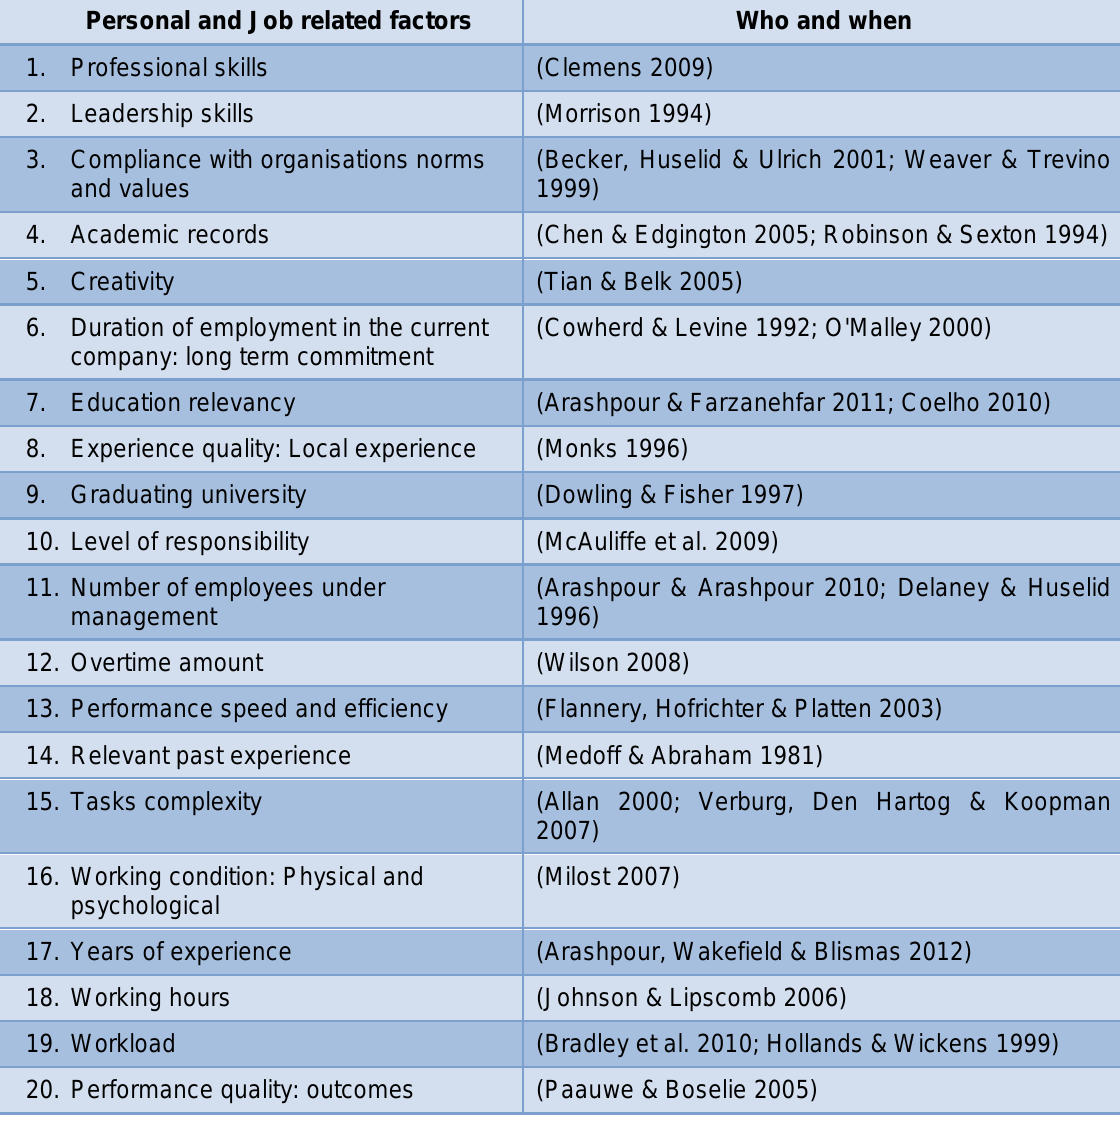
Table 1 Summary of personal and job related factors influencing salary calculations